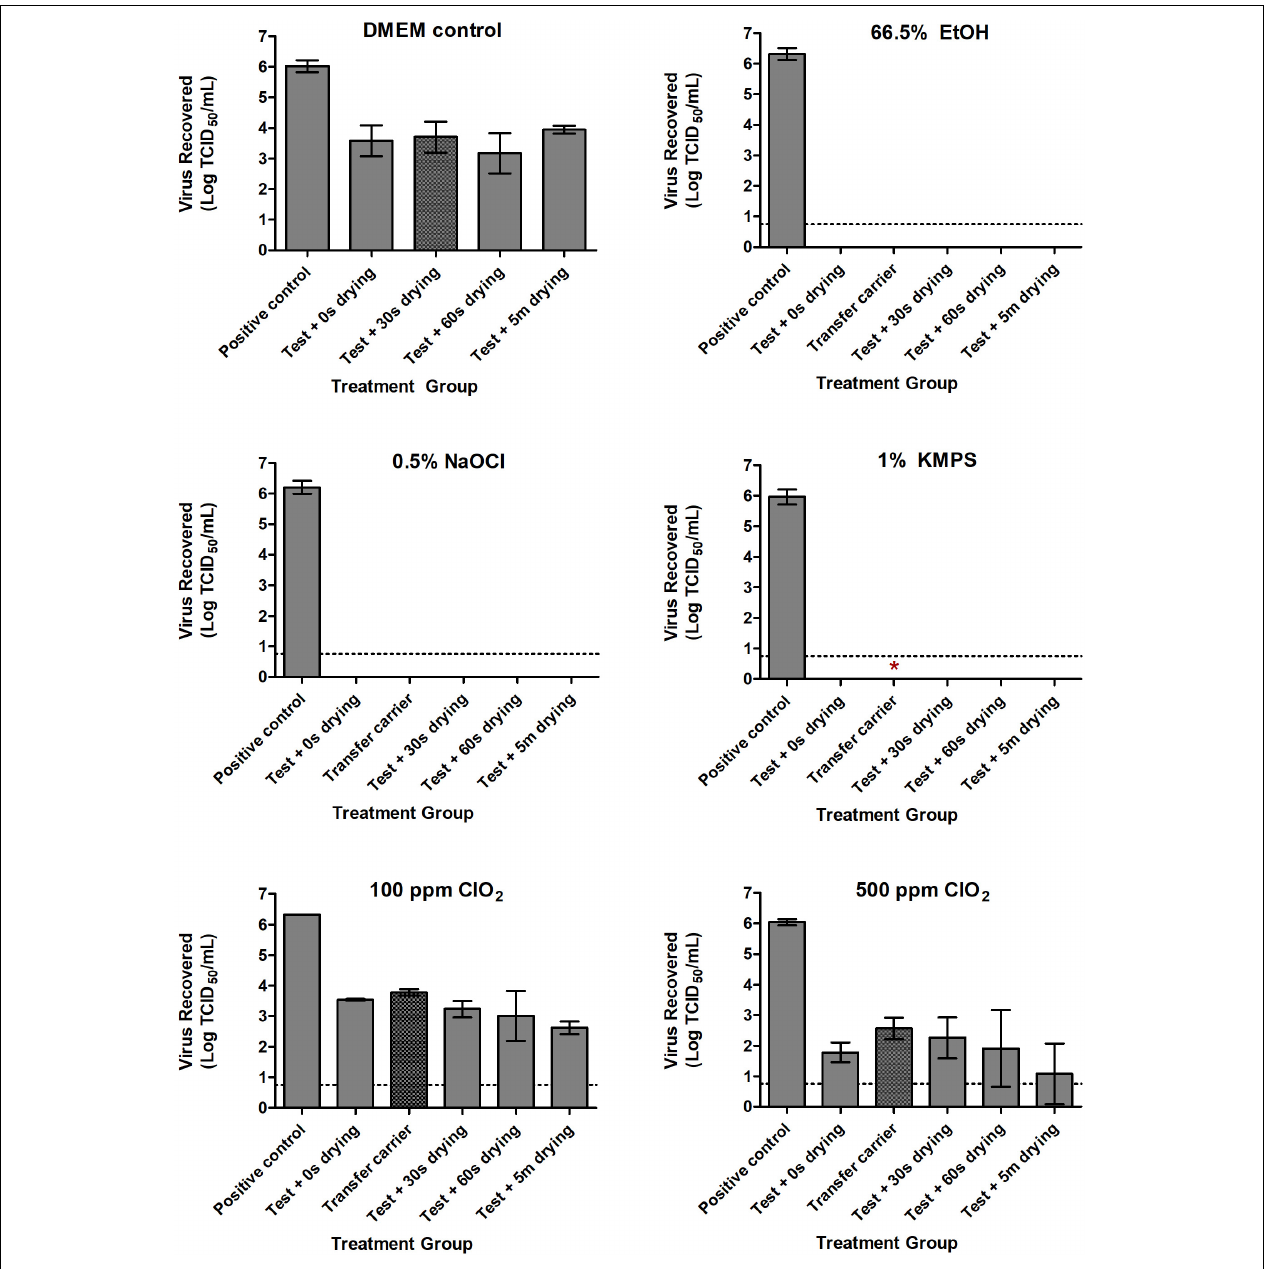
FIGURE 2 | Inactivation of SARS-CoV-2 with Dulbecco’s Modified Eagle Medium (DMEM; positive control), 66.5% ethanol (EtOH), 0.5% sodium hypochlorite (NaOCl), 1% potassium monopersulfate (KMPS), 100 ppm chlorine dioxide (ClO 2 ), and 500 ppm ClO 2 during the Wiperator assay. Inoculated carriers were subjected to 5 s of wiping with disinfectant pre-soaked wipes infused with each of the examined disinfectants. Sterile uninoculated “transfer” carriers demonstrate transfer potential of viable virus to a clean surface through a used disinfectant presoaked wipe. All carriers were neutralized in 1 ml of a pre-determined neutralizer following indicated treatments, with subsequent viability testing in Vero E6 cells. Dashed lines indicate limits of quantification using the TCID 50 assay. Results represent the means of three independent experiments including three biological replicates each. Symbol *Indicates presence of viable virus in safety testing of a single biological replicate from the indicated treatment